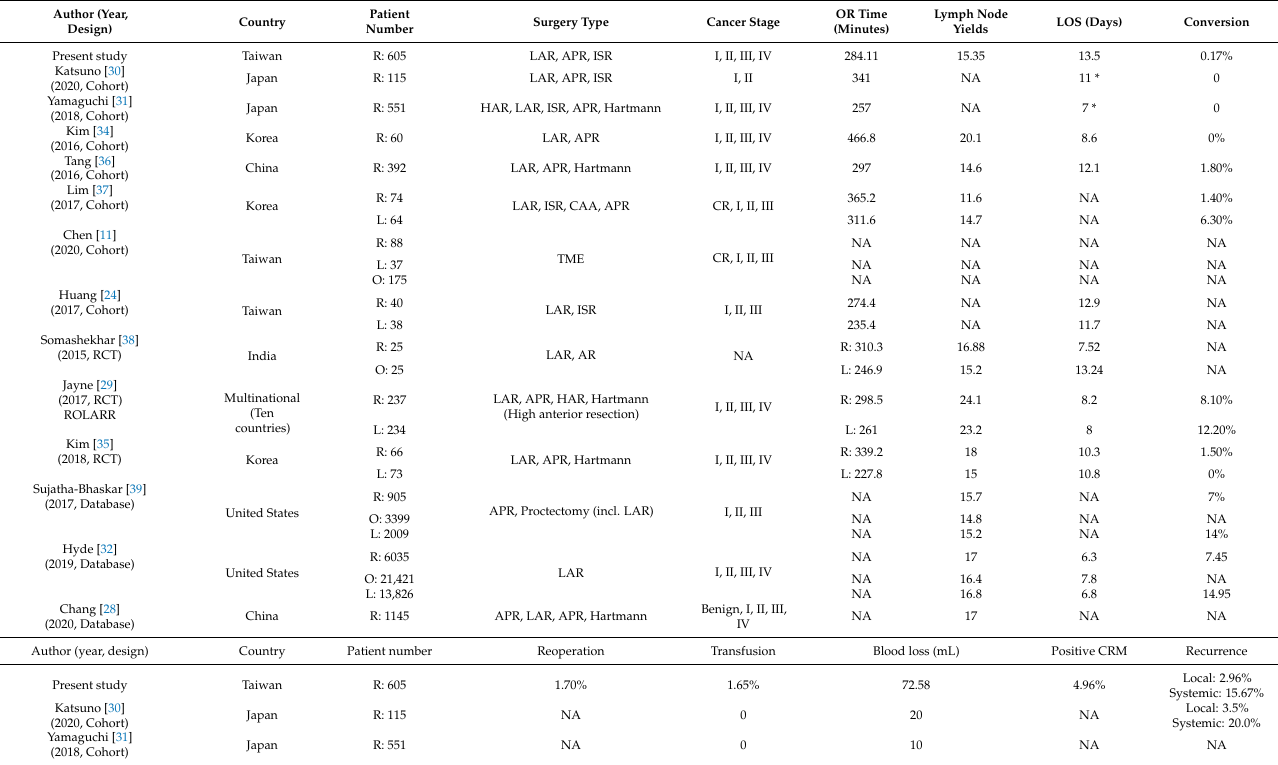
Table 4. Surgery characteristics of studies from relevant